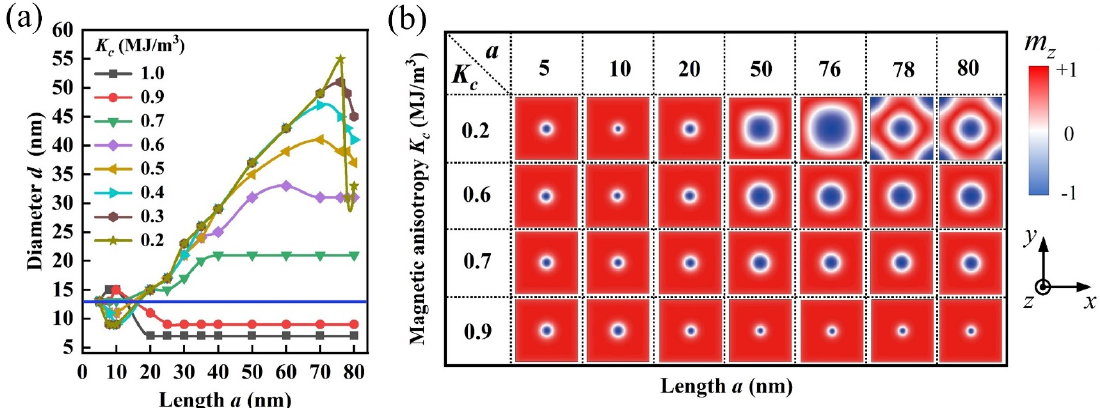
Figure 2. Effect of inhomogeneous PMA distribution on the structure of skyrmion. ( a ) Plots of skyrmion diameter d as a function of a under various fixed K c . Here the blue straight line marks the case of homogeneous PMA with K c = 0.8 MJ/m 3 . ( b ) The spatial profile of the z -component of some typical magnetization configurations in the nanostructures under various a and K c . Here all the shown areas are 80 nm × 80 nm in size for the